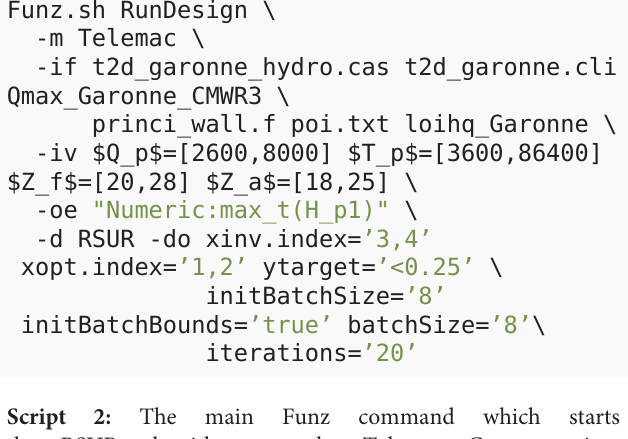
The main Funz script ( Script 2 ) then starts the RSUR algorithm on the Telemac Garonne model, which is compiled (meaning study parameters are inserted in the template model files) and sent to the EC2 instances as required when the RSUR asks for a calculation